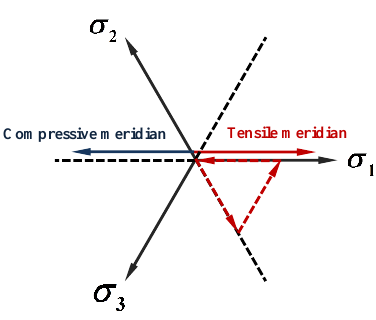
Figure 4. Stress path of tensile and compressive meridians.